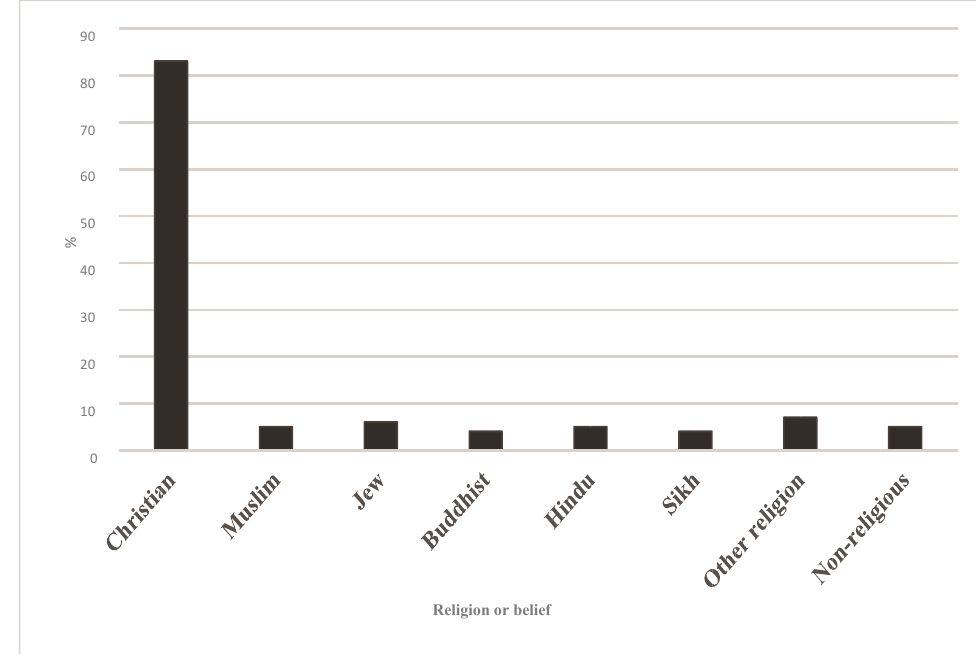
Figure 1. Perceptions of a chaplain’s religion or belief.